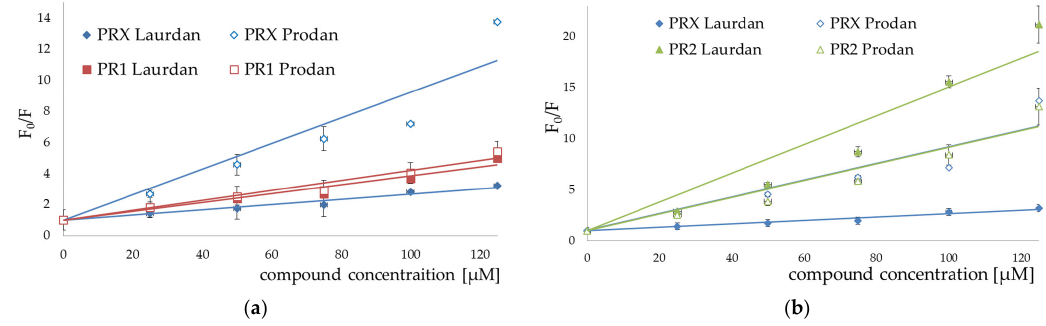
Figure 7. Stern–Volmer plots for quenching of Laurdan (full symbols) and Prodan (open symbols) fluorescence induced by PR1 ( a ) and PR2 ( b ); mean ± SD, n = 3. Stern–Volmer plots for piroxicam (PRX)-induced quenching of Laurdan and Prodan fluorescence are also provided for comparison. Bars represent standard deviations of three independent experiments. Where no error bars are shown, it means that they were smaller than the symbols representing the results.